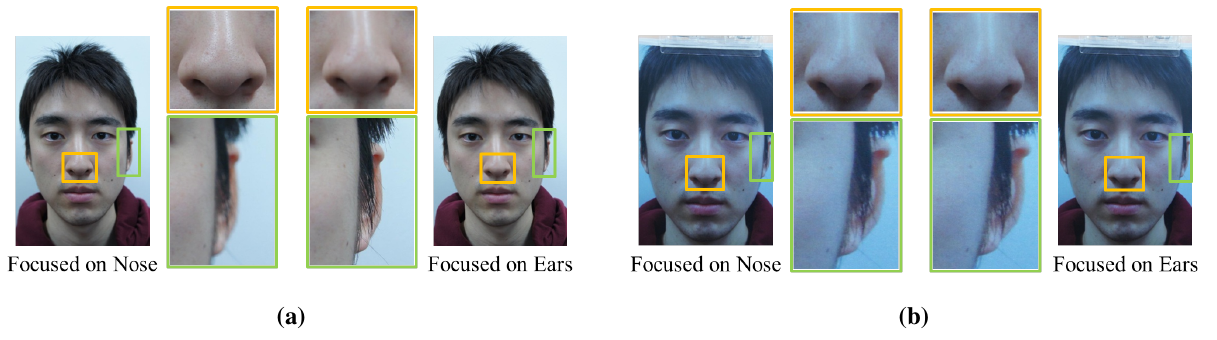
Figure 2. Partially focused images of ( a ) real faces and ( b ) fake